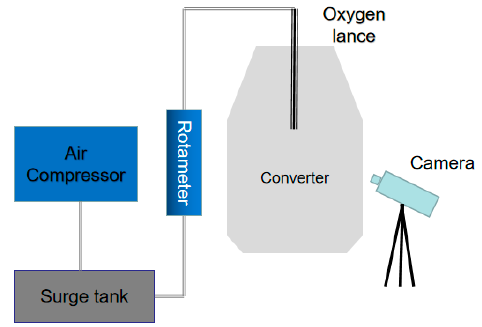
Figure 2. Schematic diagram of experimental equipment.